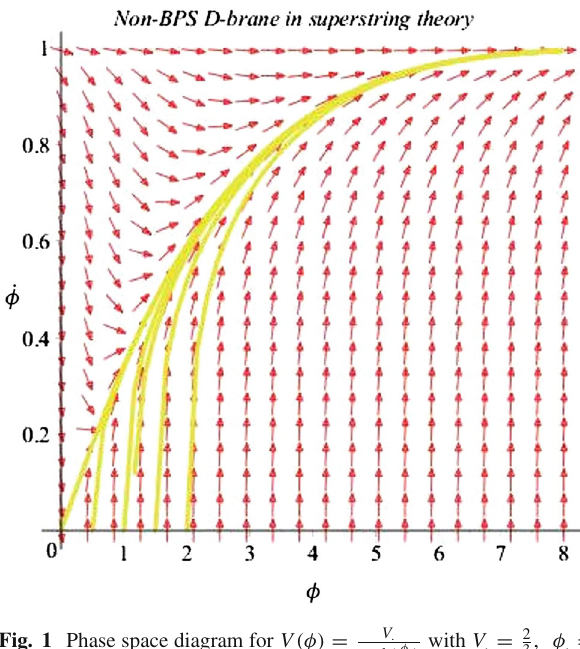
Fig. 1 Phase space diagram for V (φ) = V . √ 2 and coupling constant f (φ) = 1